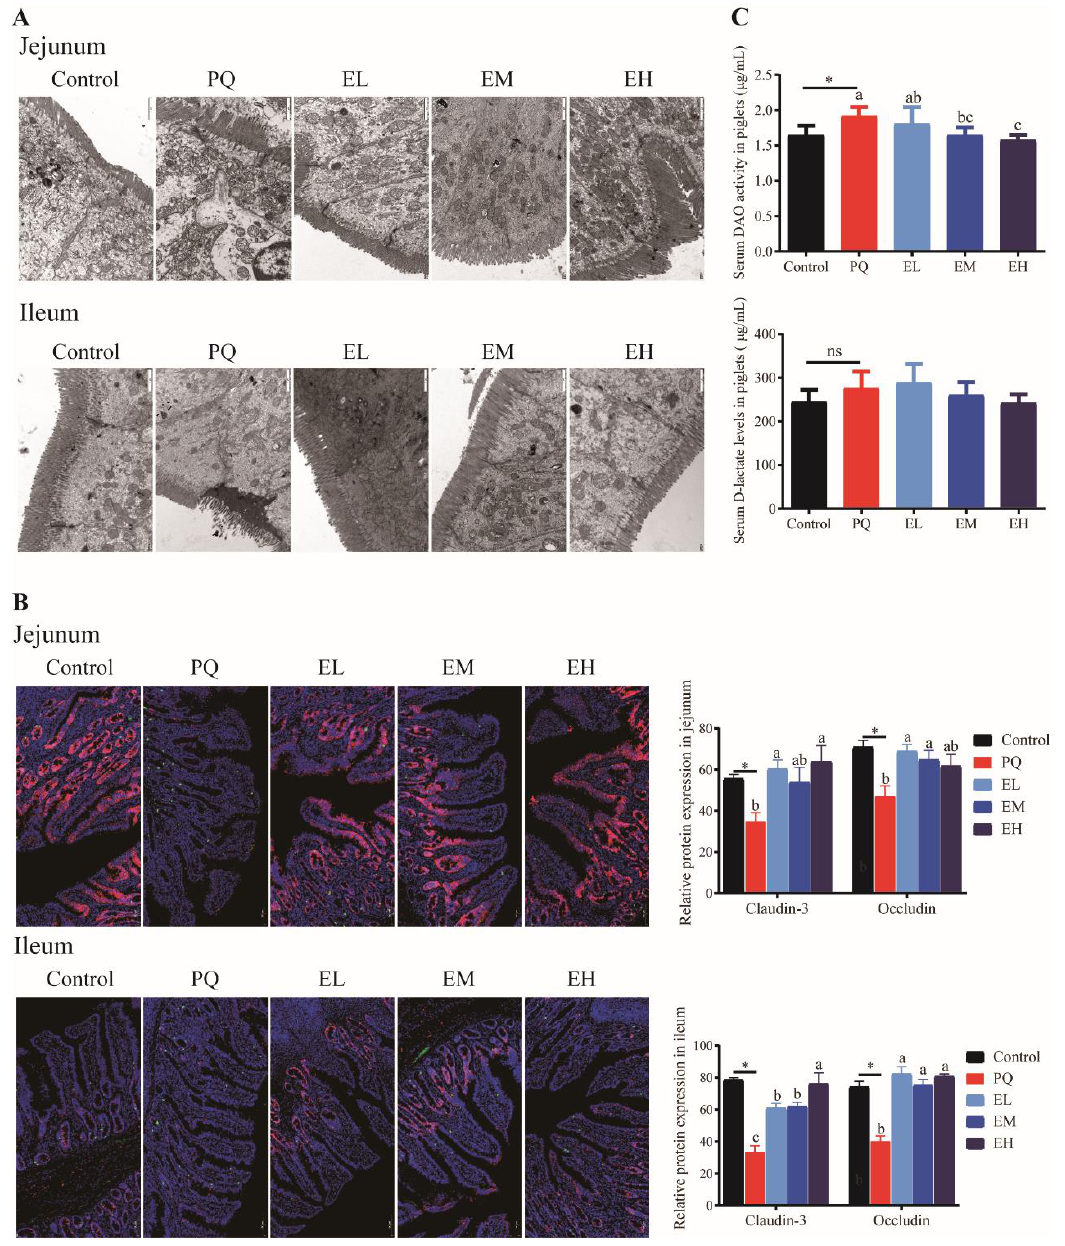
Figure 4. Tight junction structure and permeability of jejunal and ileal mucosa of piglets. ( A ) Representative electron photomicrograph and quantification of microvillus and tight junction; the microvillus and the tight junction are indicated by the black arrow and the white arrow, respectively. ( B ) The expression of tight junction proteins (Red: Claudin3; green: Occludin) in jejunal and ileal mucosa. ( C ) Serum diamine oxidase (DAO) and D-lactate (DLA) levels. PQ = 4 mg/kg paraquet; EL = 0.005% ellagic acid + 4 mg/kg paraquet; EM = 0.01% ellagic acid + 4 mg/kg paraquet; EH = 0.02% ellagic acid + 4 mg/kg paraquet. n = 8. Data are shown as mean ± SEM. * means the difference was significant when compared to the control group. ns means the difference was not significant when compared to the control group. a – c Values with different lowercase letters are significantly different among PQ, EL, EM, and EH groups ( p < 0.05).